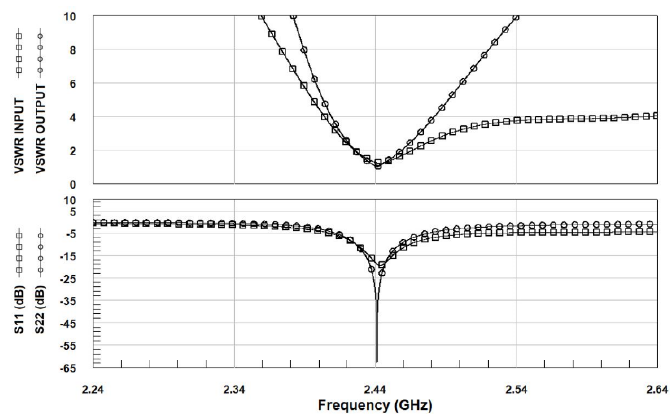
Figure 18. LNA input and output return lost ( S 11 and S 22 ), and input and output VSWR (simulation results).